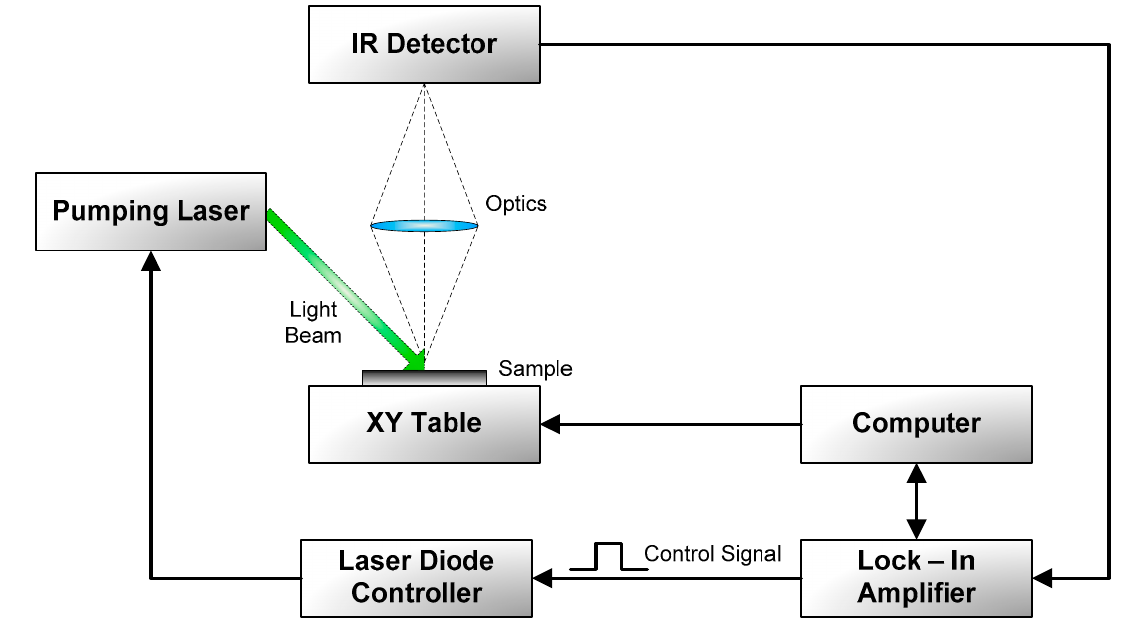
Figure 1. Schematic block diagram of the experimental setup used for the PTR frequency characteristics measurements.